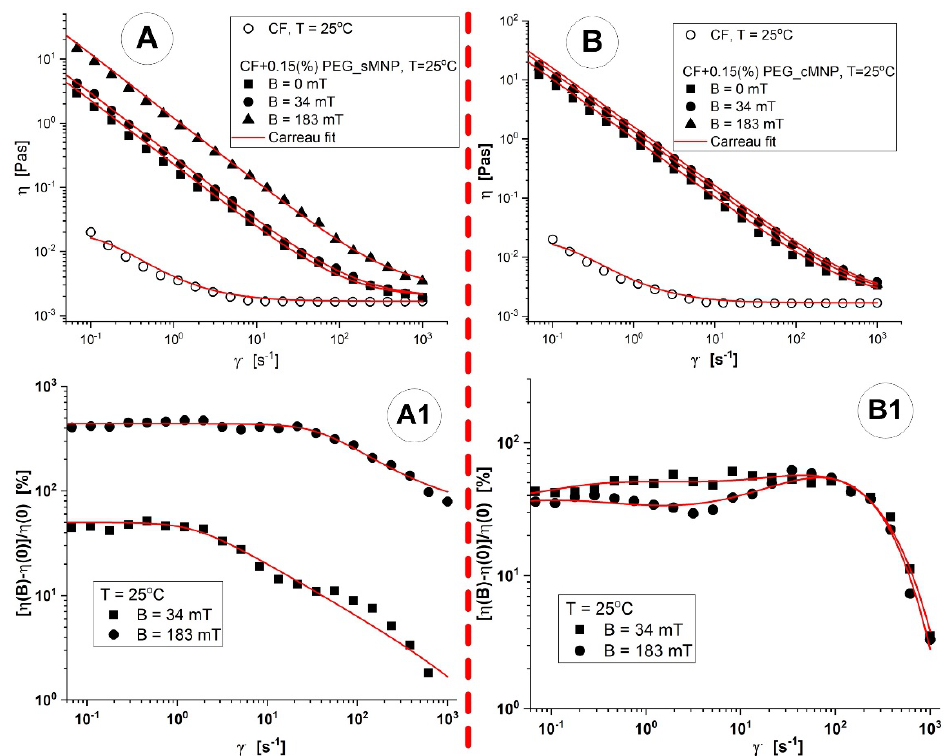
Figure 13. The model suspension viscosity curve in the presence and absence of the magnetic field: ( A ) suspension with spherical MNPs; ( B ) suspension with cubic MNPs. Magneto-viscous effects (MVE) as a function of shear rate at different magnetic flux densities: ( A1 ) for suspension with spherical MNPs and ( B1 ) suspension with cubic MNPs. CF—carrier fluid. All measurements were made at temperature T = 25 ◦